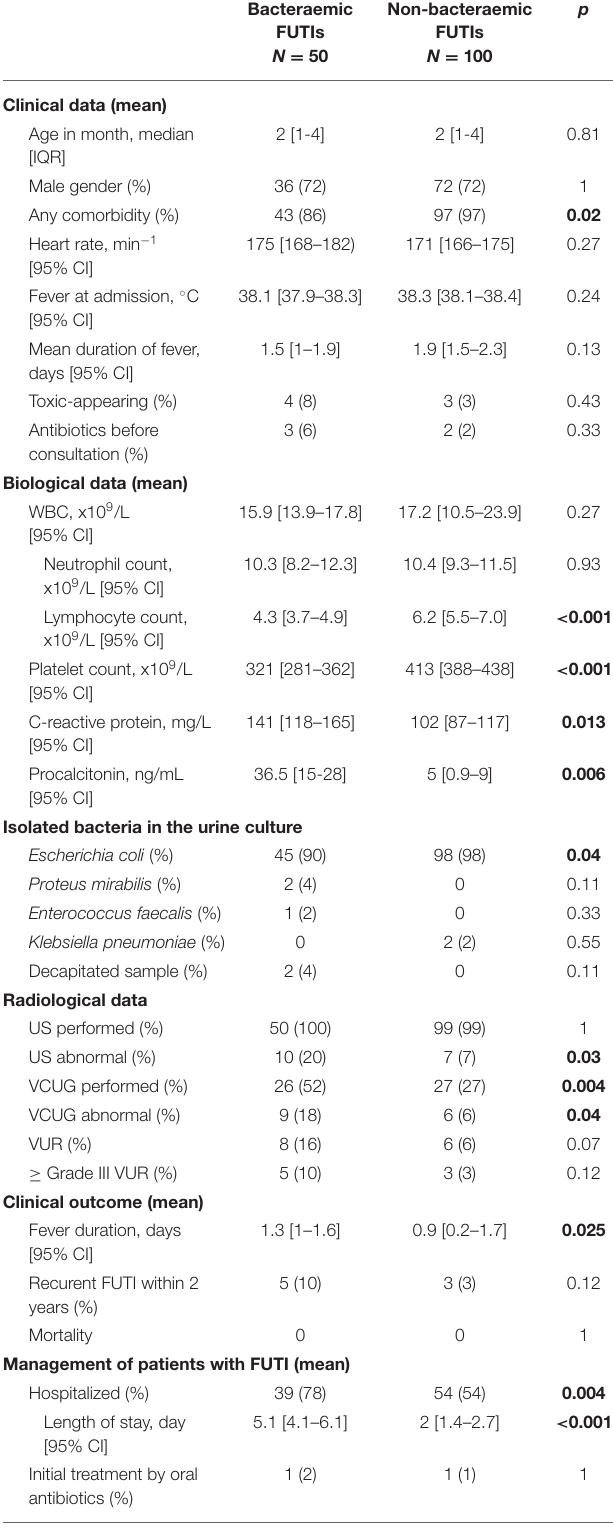
TABLE 1 | Clinical, microbiological, imaging characteristics and management of patients with FUTI. Bacteraemic